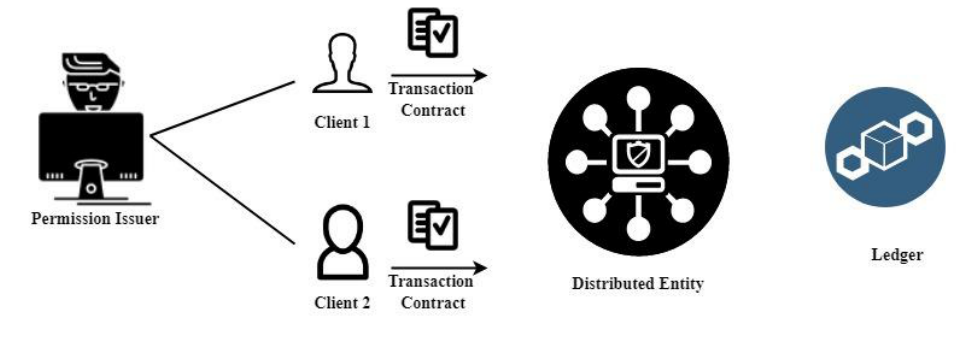
Figure 5. Hyperledger fabric